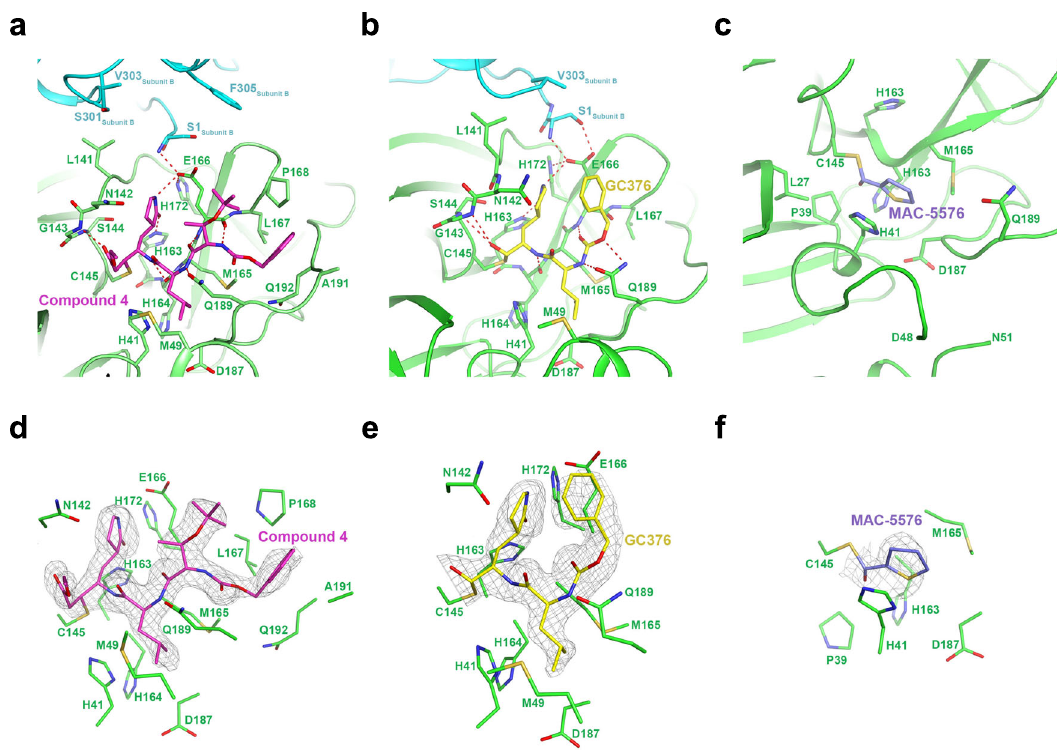
Fig. 3 Crystal structures of inhibitors in complex with the SARS-CoV-2 3CL protease. Structure of compound 4 ( a ), GC376 ( b ), or MAC-5576 ( c ) bound to SARS-CoV-2 3CL pro . Protomer A is denoted in green and protomer B is denoted in cyan. The Fo – Fc omit map, contoured at 3 σ (gray), for compound 4 ( d ), GC376 ( e ), and MAC-5576 ( f